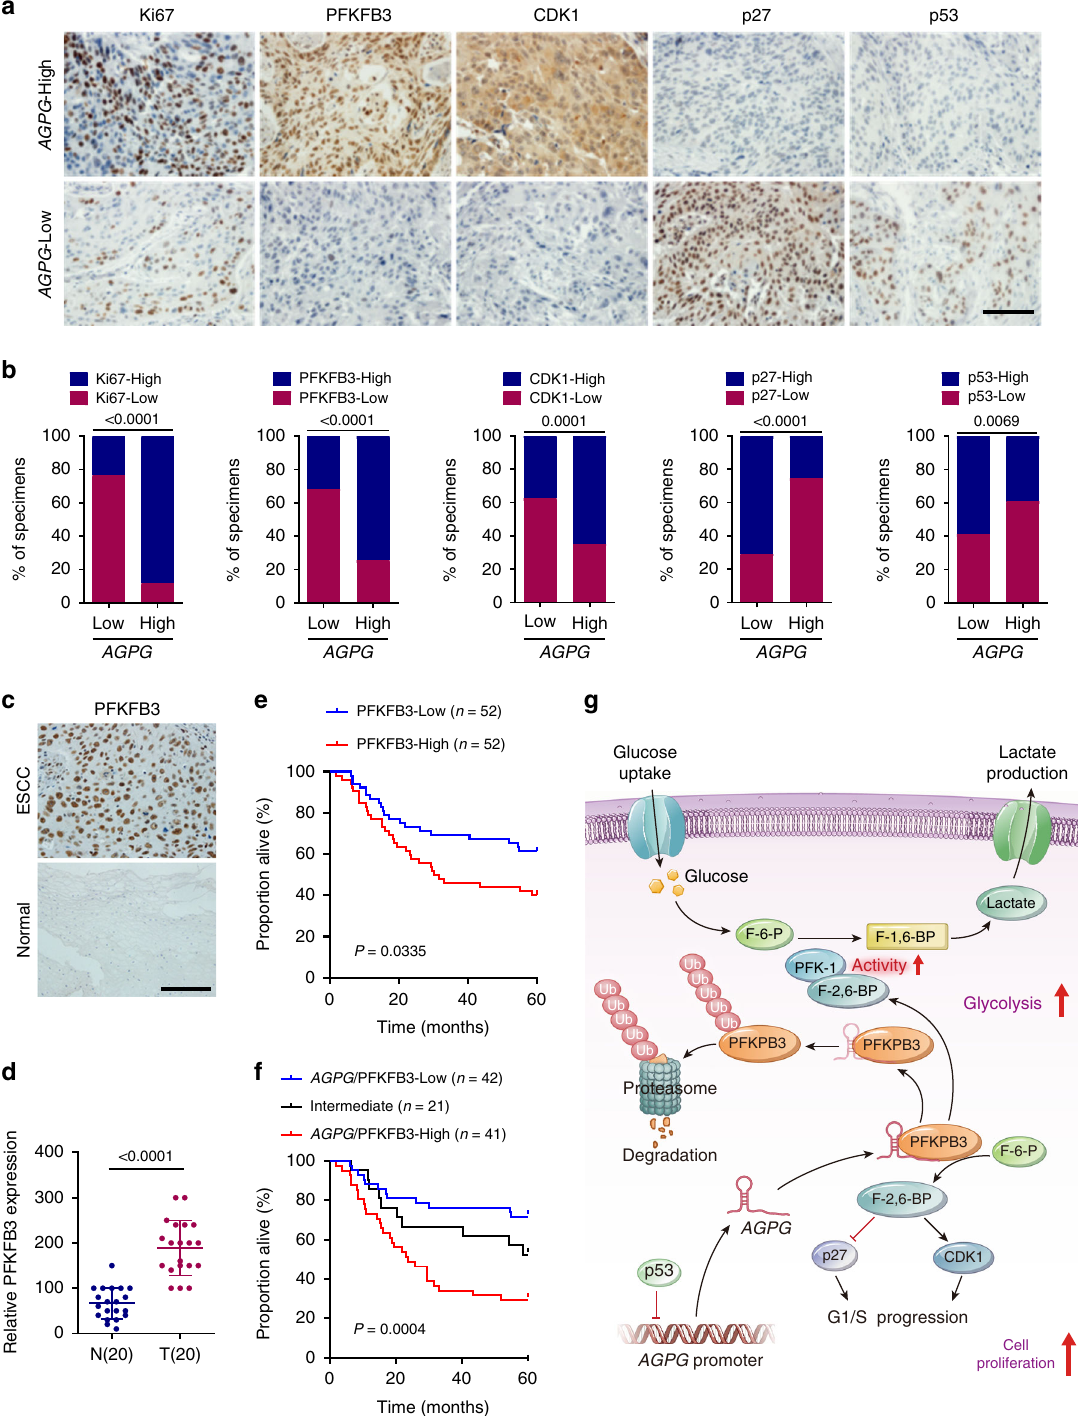
Fig. 7 Clinical relevance of the p53- AGPG -PFKFB3 axis in ESCC. a Representative IHC staining for Ki67, PFKFB3, CDK1, p27, and p53 in ESCC patients (SYSUCC, n = 104) with low or high AGPG expression. Scale bar, 100 µ m. b Percentage of specimens with low or high Ki67, PFKFB3, CDK1, p27, and p53 expression in the low or high AGPG expression groups (SYSUCC, n = 104, Chi-square test, two-sided). c , d Representative IHC images and statistical analysis of PFKFB3 expression in ESCC and matched normal tissues (SYSUCC). Scale bar, 100 µ m. Data are representative of three independent experiments and presented as mean±S.D., n = 20 cases, the P value was determined by a two-tailed unpaired Student ’ s t test. e Kaplan – Meier analysis of the overall survival of ESCC patients (SYSUCC) with low ( n = 52) or high ( n = 52) PFKFB3 expression (log-rank test, two-sided). f Kaplan – Meier analysis of overall survival of ESCC patients (SYSUCC) with low (low expression of both AGPG and PFKFB3, n = 42), high (high expression of both AGPG and PFKFB3, n = 41) or intermediate ( n = 21) AGPG /PFKFB3 expression (log-rank test, two-sided). g Graphical abstract showing that the lncRNA AGPG regulates glucose metabolism remodeling by affecting PFKFB3